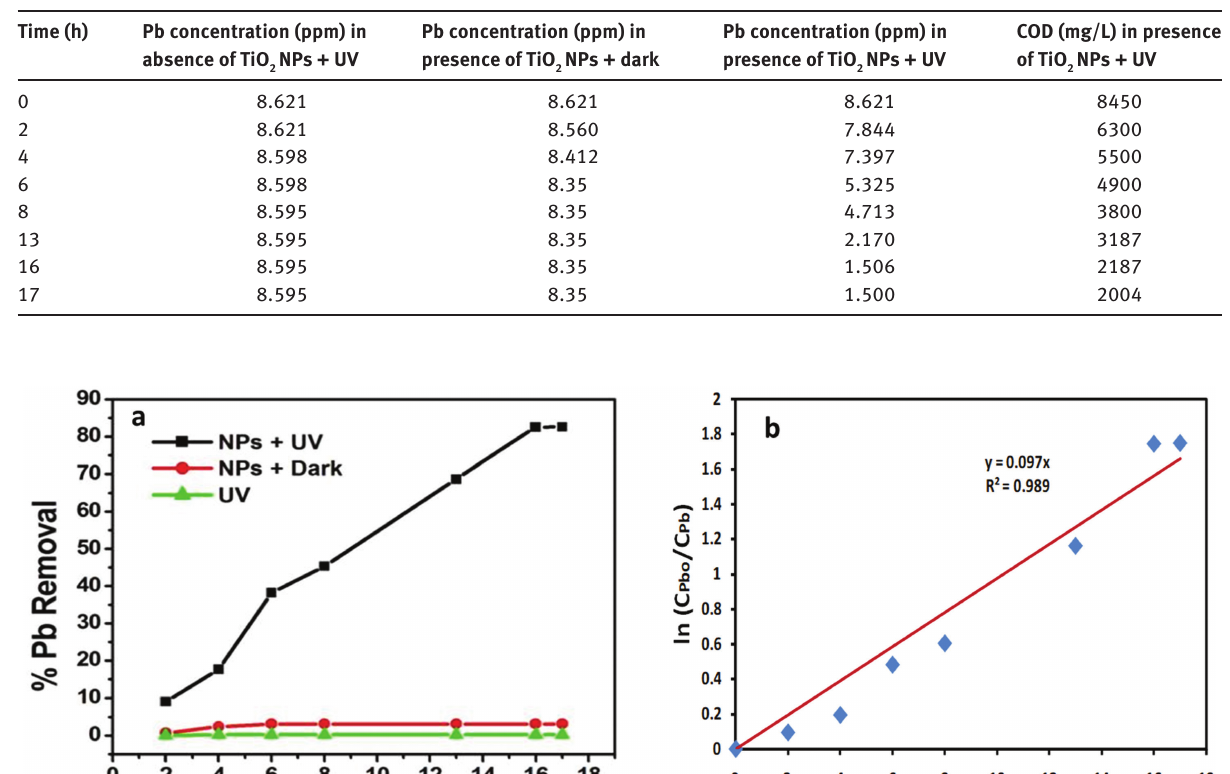
Figure 8: (a) Pb removal profile in UV and dark condition in the presence of synthesized TiO synthesized TiO NPs. 2